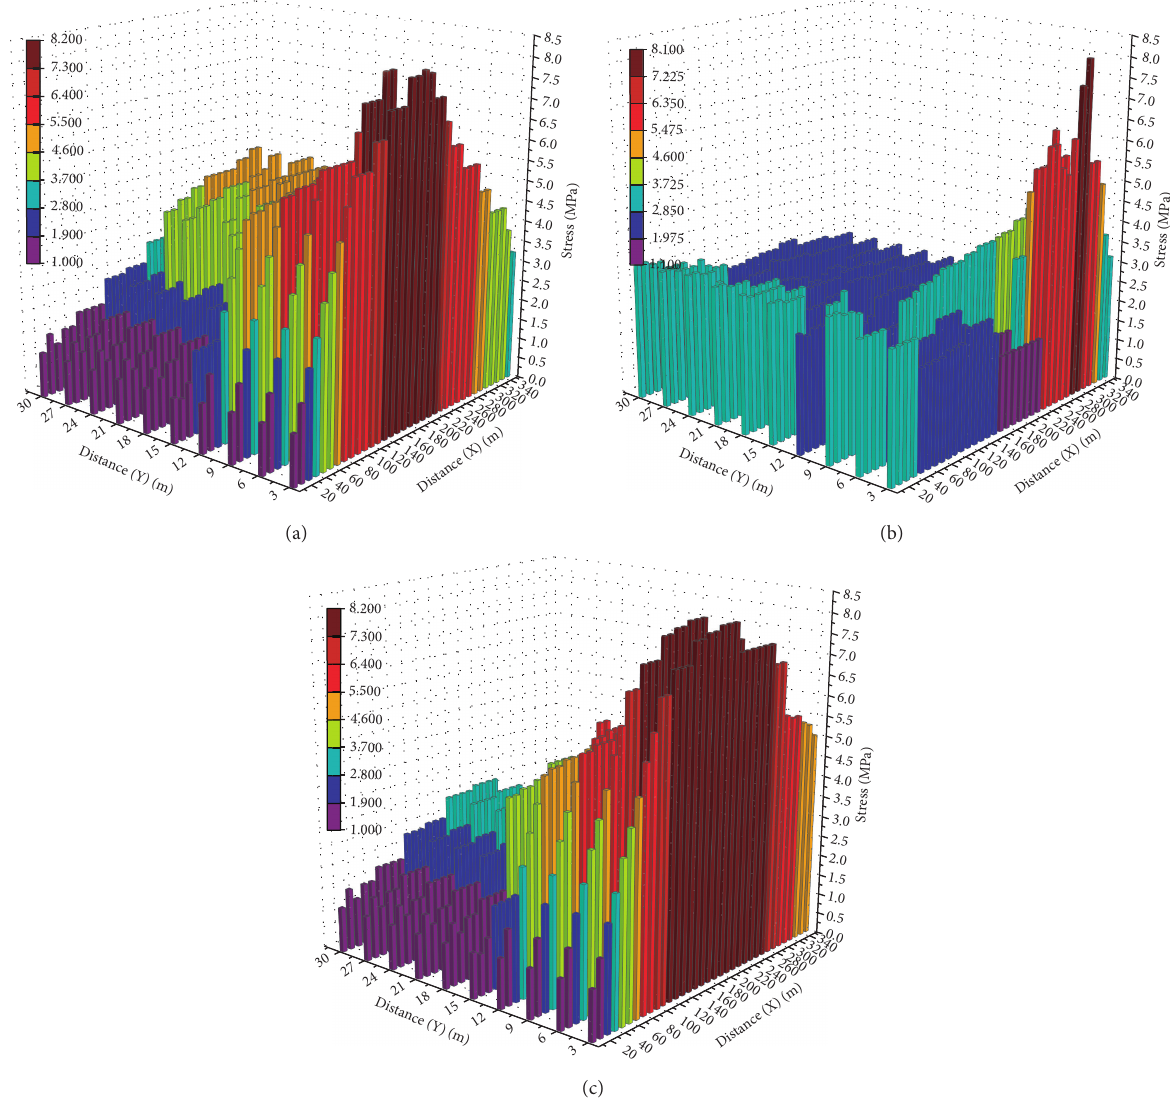
Figure 9: The 3D bars of the stress distribution. (a) +590m level. (b) +525m level. (c) +500 m